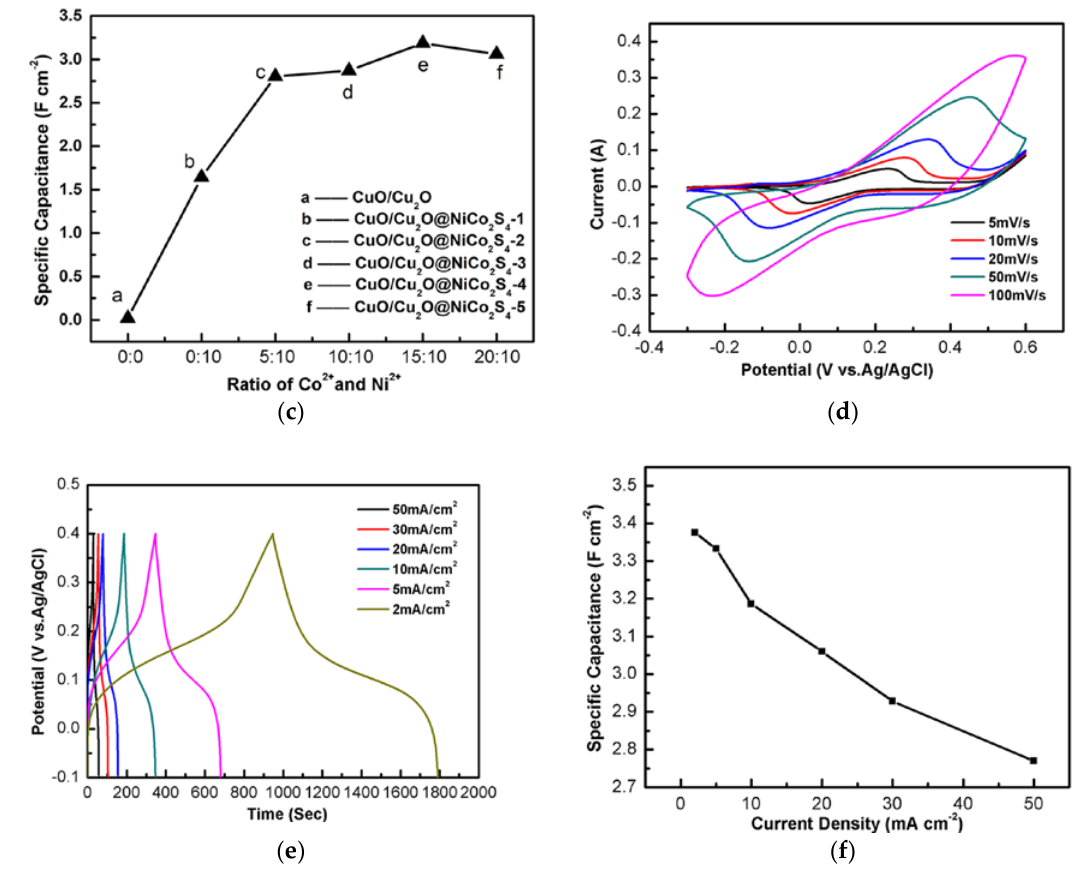
Figure 5. ( a ) Cyclic voltammetry (CV) curves at a scan rate of 20 mV s − 1 and ( b ) galvanostatic charge–discharge (GCD) curves of all the CuO/Cu 2 O@NiCo 2 S 4 electrodes at a current density of 10 mA cm − 2 ; ( c ) Specific capacitance of CuO/Cu 2 O@NiCo 2 S 4 composites as a function of ratio of Co 2+ /Ni 2+ at a current density of 10 mA cm − 2 ; ( d ) CV curves of the CuO/Cu 2 O@NiCo 2 S 4 -4 electrode; ( e ) GCD curves of the CuO/Cu 2 O@NiCo 2 S 4 -4 electrode; ( f ) specific capacitance of CuO/Cu 2 O@NiCo 2 S 4 -4 electrode at different current densities.